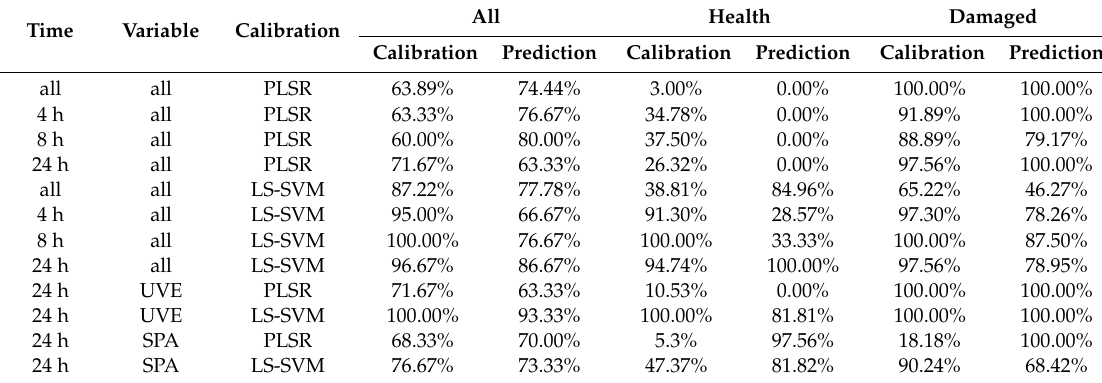
Table 4. Discrimination of damaged